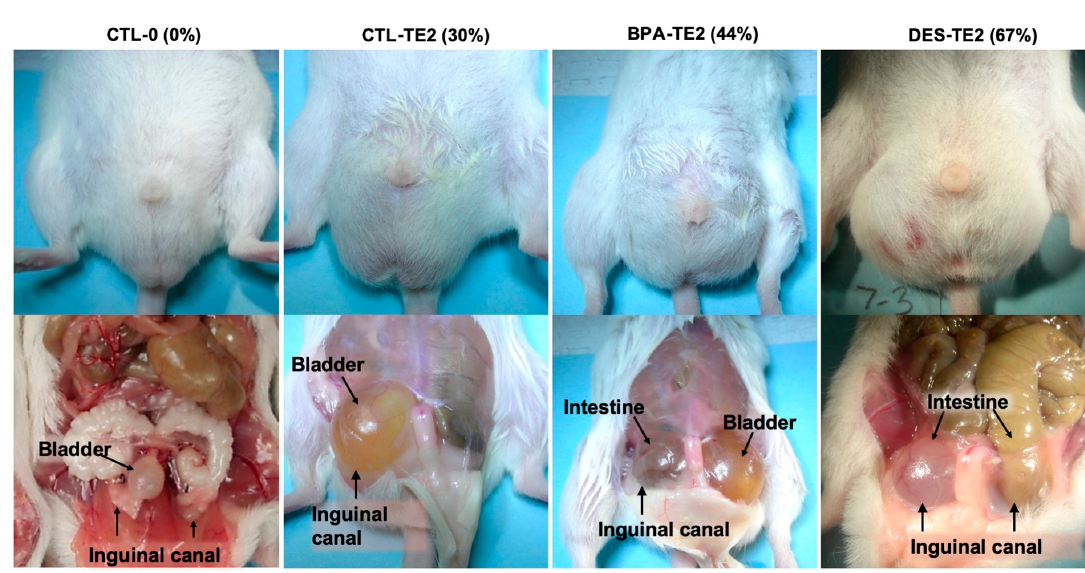
Figure 4. Examples of the effect of T+E2 treatment on inguinal hernias observed in this study, also showing the percent of males within each T+E2 group with inguinal hernias (only T+E2-treated males showed inguinal hernias). CTL-0 is an untreated normal male, and the lower panel shows the absence of an inguinal hernia. CTL-TE2 is a perinatal untreated male exposed to T and E2 in adulthood. The top panel shows the wetness of fur around the penis indicative of droplet voiding, and the bottom panel shows an enlarged bladder in the right inguinal canal. BPA-TE2 is a male treated perinatally with BPA and then T and E2 in adulthood. The top panel shows the wetness of fur around penis, and the bottom panel shows an enlarged bladder herniated on the left side and the cecum herniated on the right side. DES-TE2 is a male treated perinatally with diethylstilbestrol (DES) and then T and E2 in adulthood. The top panel shows bulging in the scrotal region, and the bottom panel an intestinal herniation in the right and left inguinal canals. The incidence of hernias was significantly increased by T+E2 treatment for all perinatal treatment groups ( P < 0.01).